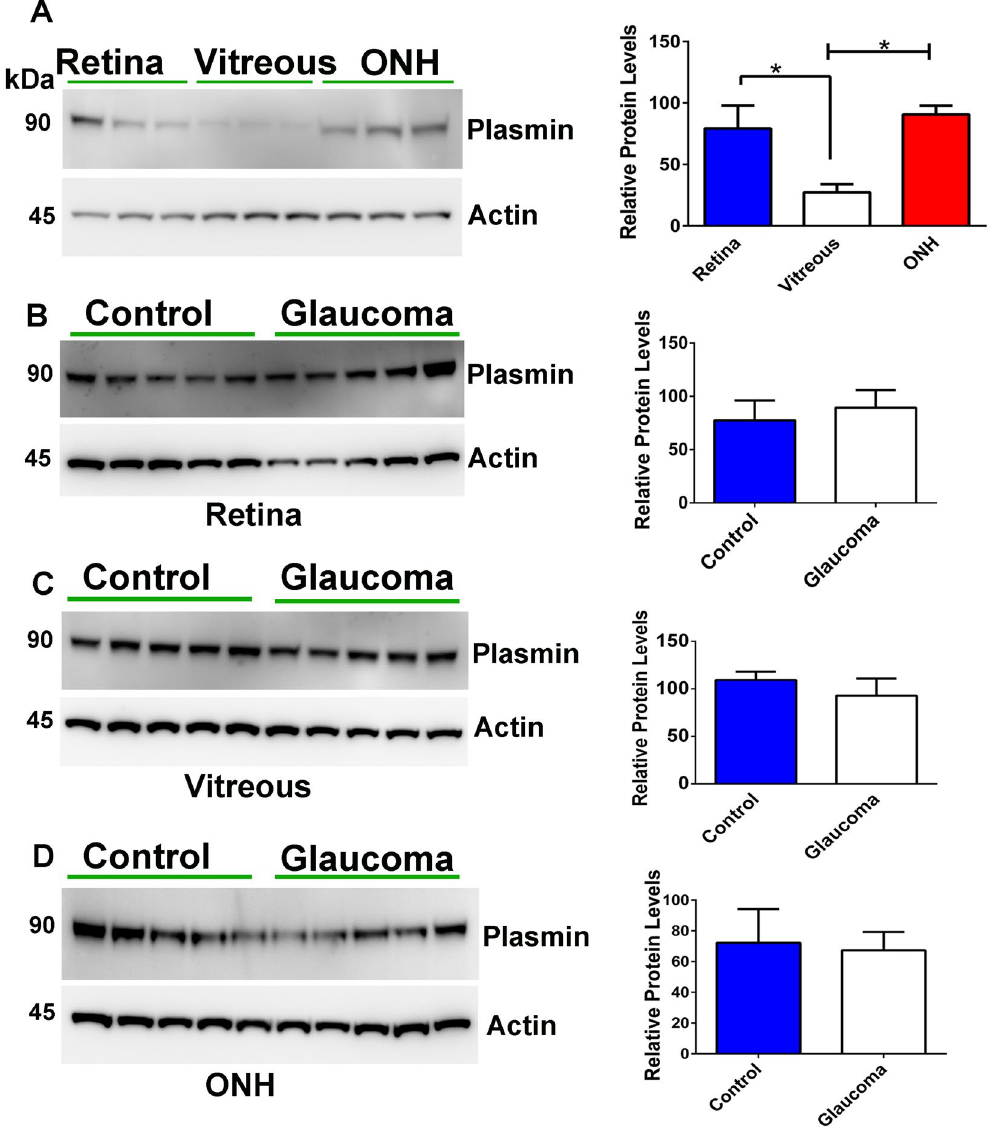
Figure 2. ( A ) Plasmin expression was evaluated in the human retina, vitreous and ONH using immunoblotting and relative band intensities quantified (n = 6; * p < 0.01). ( B–D ) Plasmin expression levels were also evaluated in the human retinal, vitreous and ONH samples from glaucoma and control subjects using western blotting and relative band intensities quantified and plotted (n = 5 each). Blots were cropped to show the relevant band. Actin was used for loading normalisation in each